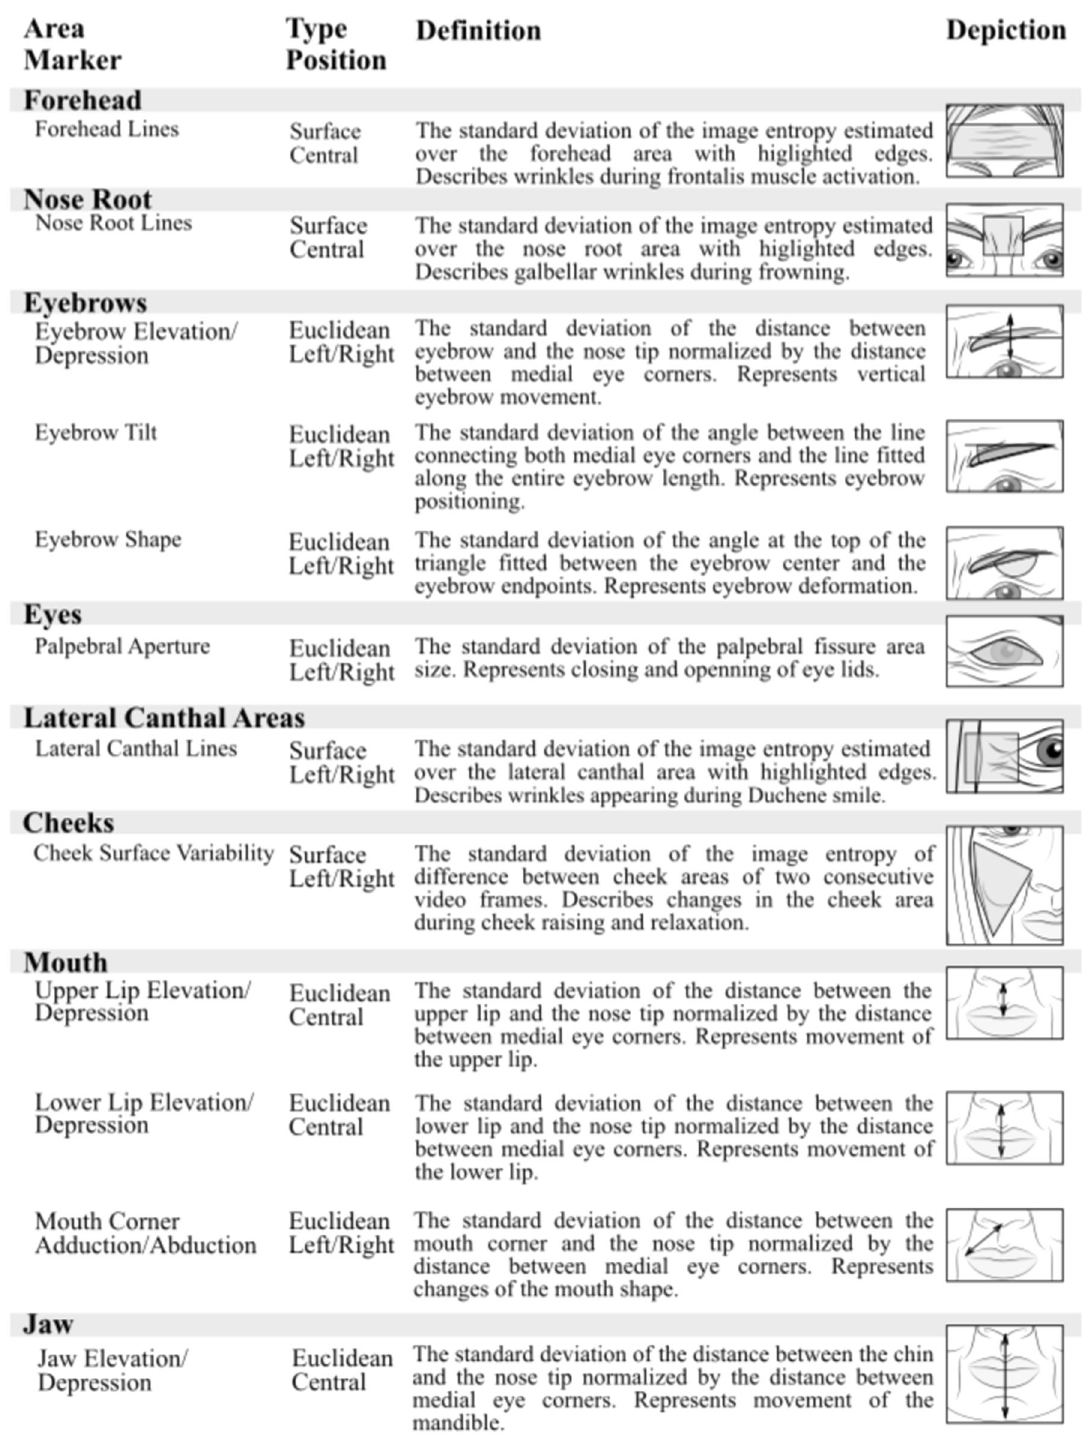
Fig. 3 Illustration of analyzed facial areas. Detailed description of assessed markers of facial dynamics. All markers are expected to decrease in parallel with increasing severity of facial bradykinesia. The cheek area was described by one surface marker with left/right variants. The cheek surface variability , de fi ned as the standard deviation of the image entropy of difference between cheek areas of two consecutive video frames, represented changes in the cheek area during the raising and relaxation of cheeks. The mouth area was described by three Euclidean markers, two markers centered along the vertical axis and one with left/right variants. The upper lip elevation/depression , de fi ned as the standard deviation of the distance between the upper lip and the nose tip normalized by the distance npj Digital Medicine (2022)